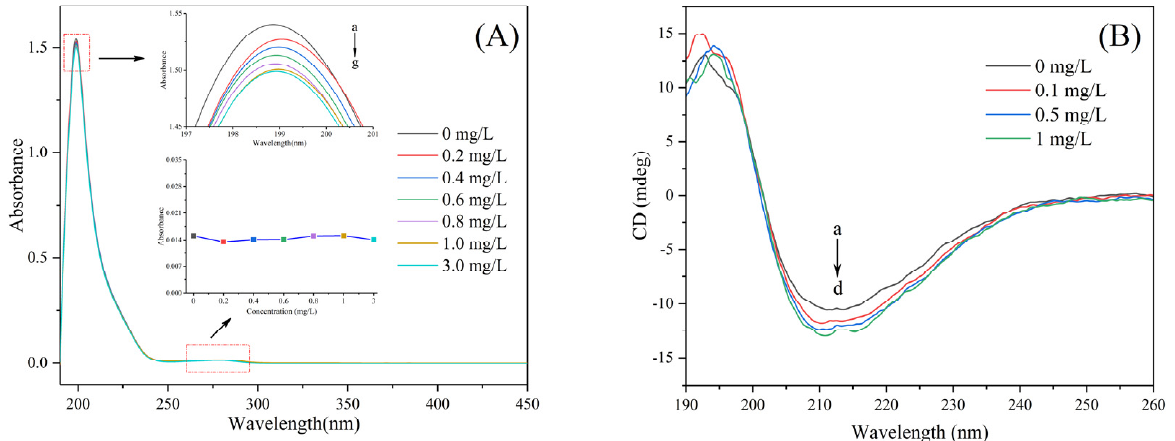
Figure 6. Changes of primary and secondary structure of SOD after IND exposure. Experimental Conditions: T = 298 K, pH = 7.4, c (SOD) of ( A ): 1 µ M, c (SOD) of ( B ): 5 µ M, c (IND) of ( A ) a–g: 0, 0.2, 0.4, 0.6, 0.8, 1.0, 3.0 mg/L, c (IND) of ( B ) a–d: 0, 0.1, 0.5, 1 mg/L.